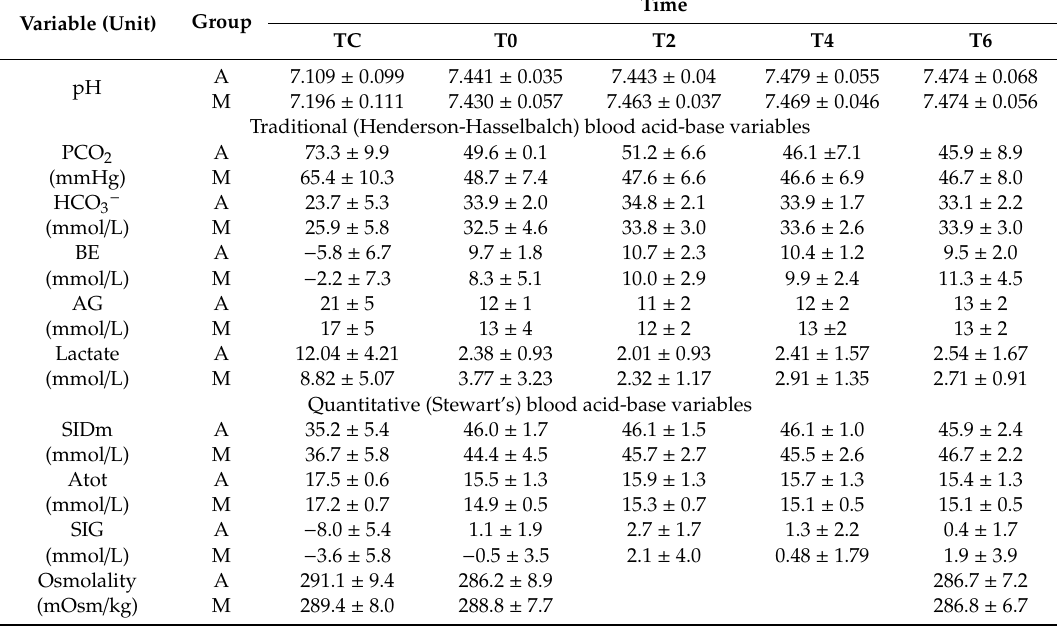
Table 1. Mean ± standard deviation for pH, venous partial pressure of carbon dioxide (PCO 2 ), bicarbonate (HCO 3 − ), base excess (BE), anion gap (AG), lactate, measured strong ion di ff erence (SIDm), non-volatile weak acids (Atot), strong ion gap (SIG) and plasma osmolality in rhinoceroses captured and transported with either azaperone (Group A) or midazolam (Group M) as a sedative. Time: capture (TC), start of transport (T0), and two (T2), four (T4) and six (T6) hours of